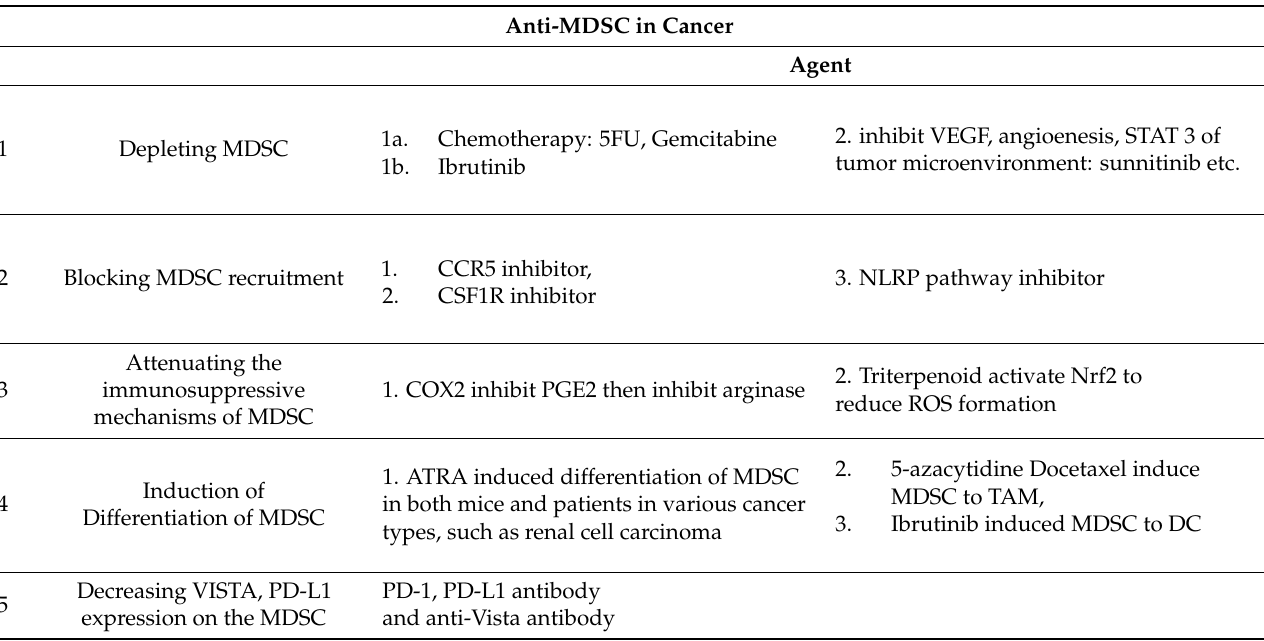
Table 1. Anti-MDSC in